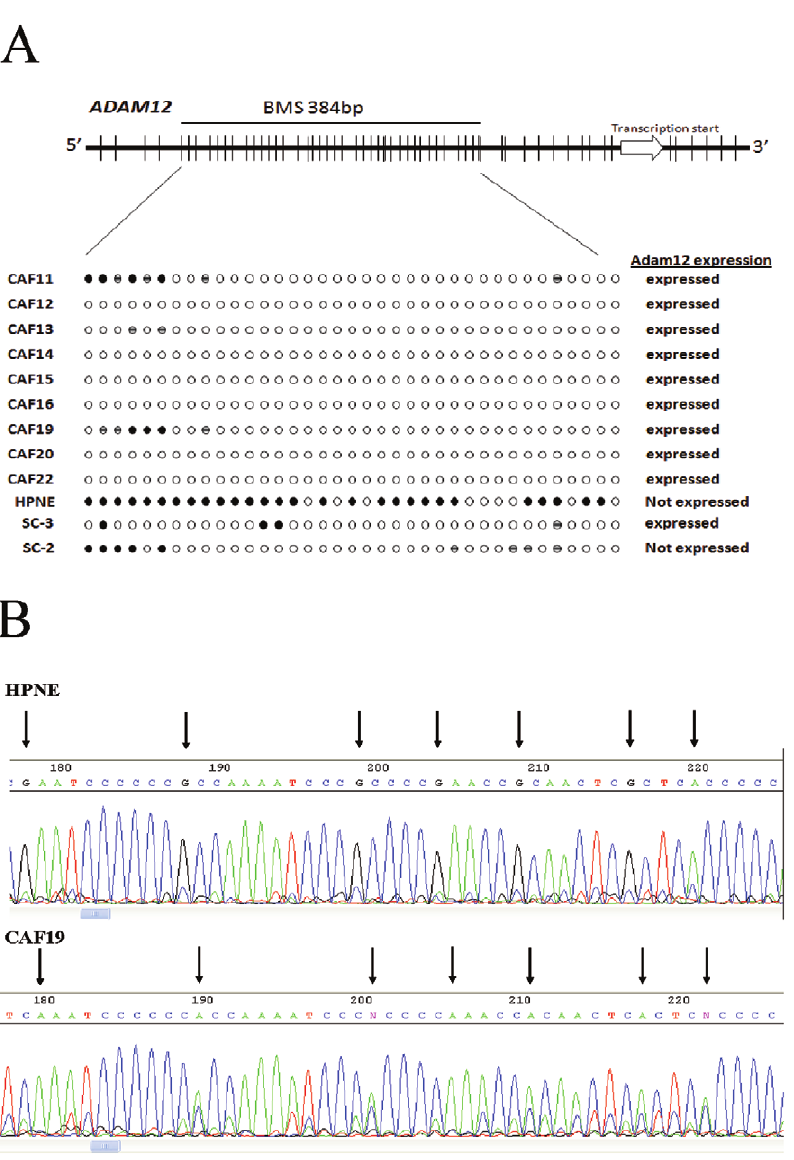
Figure 5. Bisulfite sequencing analysis of ADAM12 . (A) Top: ADAM12 gene structure and distribution of CpG dinucleotides. Short vertical bars represent CpG sites. Arrow points to transcriptional start site. Below: Bisulfite genomic sequencing analysis in pancreatic CAFs and control fibroblasts. Open circles represent unmethylated CpG sites, solid black circles methylated CpG sites, and hatched circles partially methylated CpG sites. (B) Bisulfite sequencing chromatograms of the ADAM12 promoter in a pancreatic CAF (CAF19) and control fibroblast line (HPNE). Arrows point to cytosine residues.